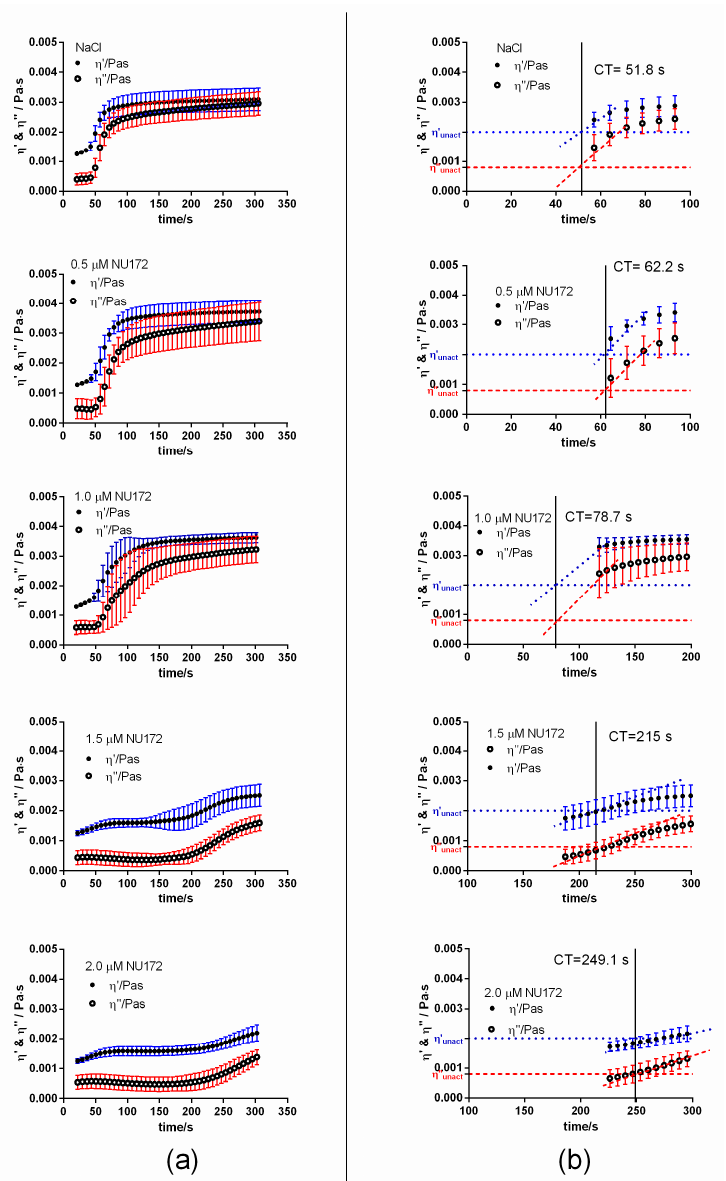
Figure 2. Detection of clotting time (CT) in citrated blood using PIEZ after the addition of 0.5, 1.0, 1.5, or 2.0 µM NU172. Mean viscous ( η ’) and elastic ( η ”) components of blood are shown after the addition of ( a ) NaCl (control), 0.5 µM, 1.0 µM, 1.5 µM, or 2.0 µM NU172. The measurements were performed at 100 Hz and 37 °C (n = 10 ± SD). ( b ) Enlarged parts of diagrams for the calculation of CT. The horizontal dotted blue line at 0.002 Pa·s visualizes the η ’ and the dashed red line at 0.0008 Pa·s visualizes the η ” of unactivated citrated blood.